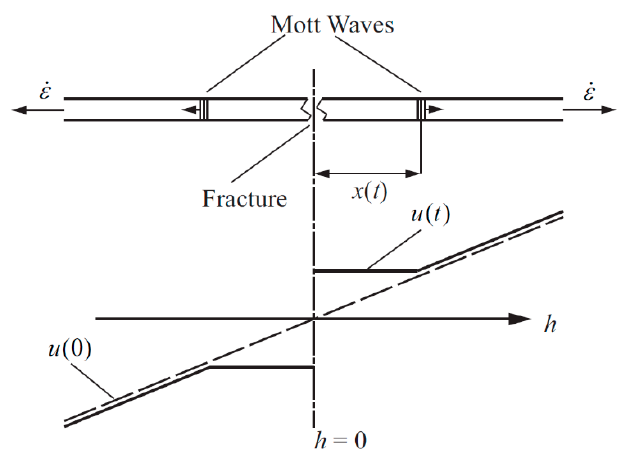
Figure 4. Circumferential velocity distribution of the Mott ring.